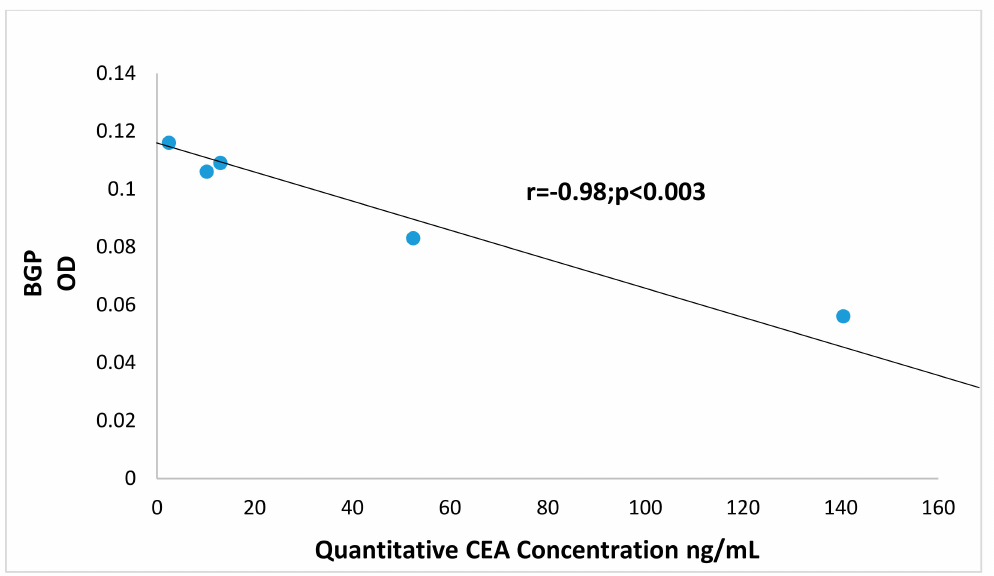
Figure 11. Normal CTT tissue correlation of BGP versus CEA in ng / mL shows an inverse relationship. The scatter gram plot shows a statistically significant correlation between BGP and CEA concentration. There was a similar correlation between BGP and CEA concentration when expressing the results in ng / mg protein in these normal-appearing mucosal sample CTT extracts. These extracts shown here are identical to the normal CTT shown in Figures 8–10. There was no BGP versus CEA concentration correlation seen in the cancer tissue extracts. The CEA concentrations were obtained using the TOSOH Medics kit